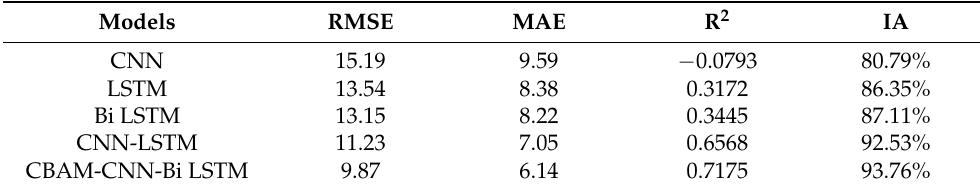
Table 10. Performance evaluation indicators for the model prediction of SO 2